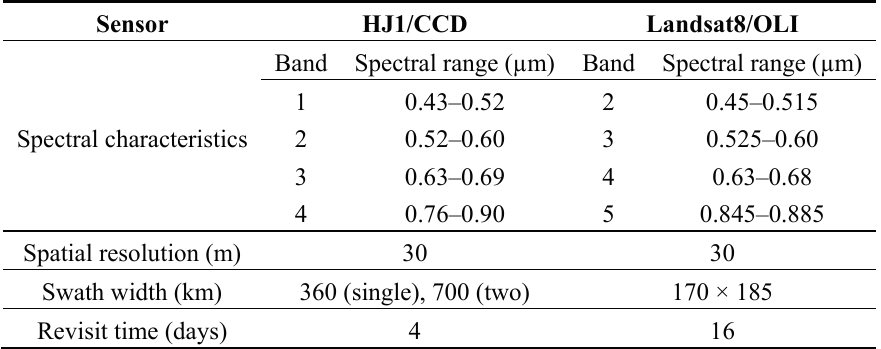
Table 1. Comparison of the sensor band settings and characteristics between HJ1/CCD and